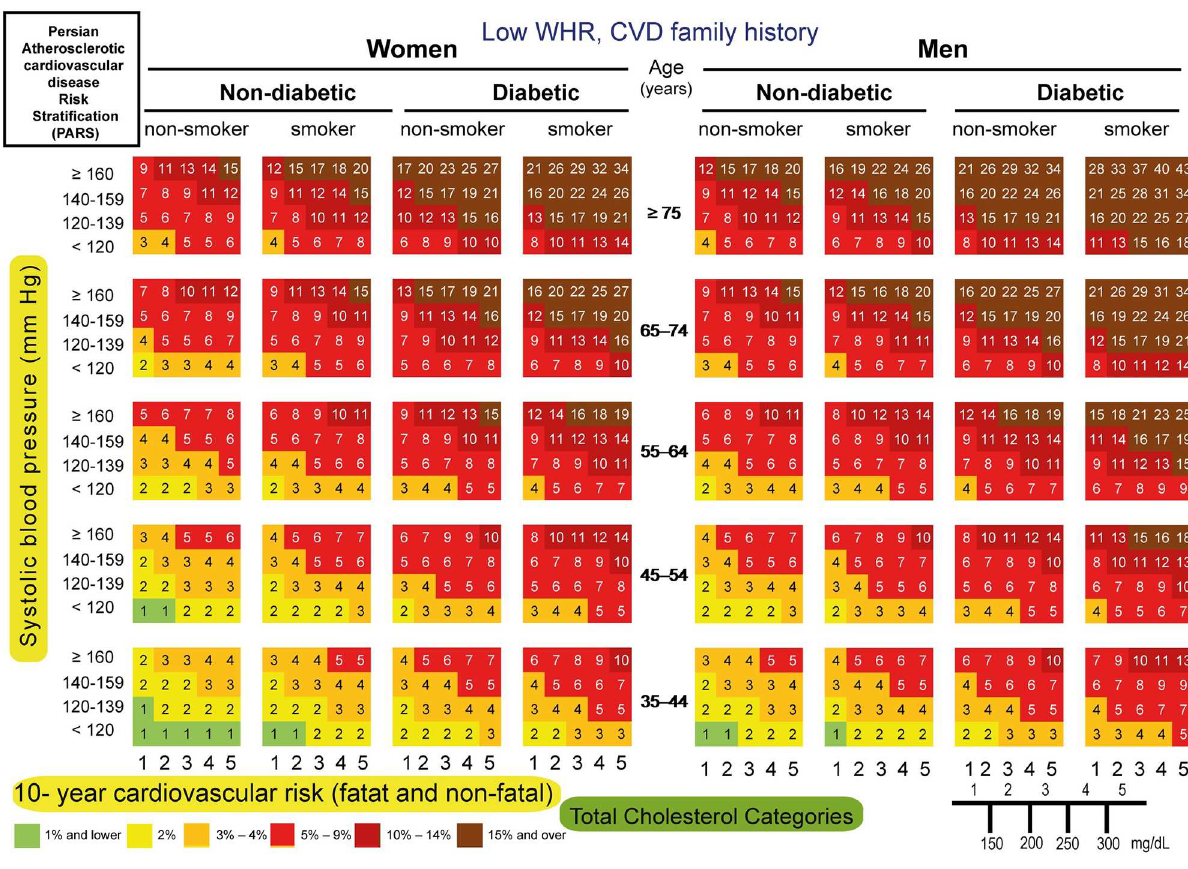
Fig 5. PARS charts for prediction of 10-year risk of fatal and non-fatal cardiovasculardisease in ICS population with lower WHR and CVD family history, 2001–2011.